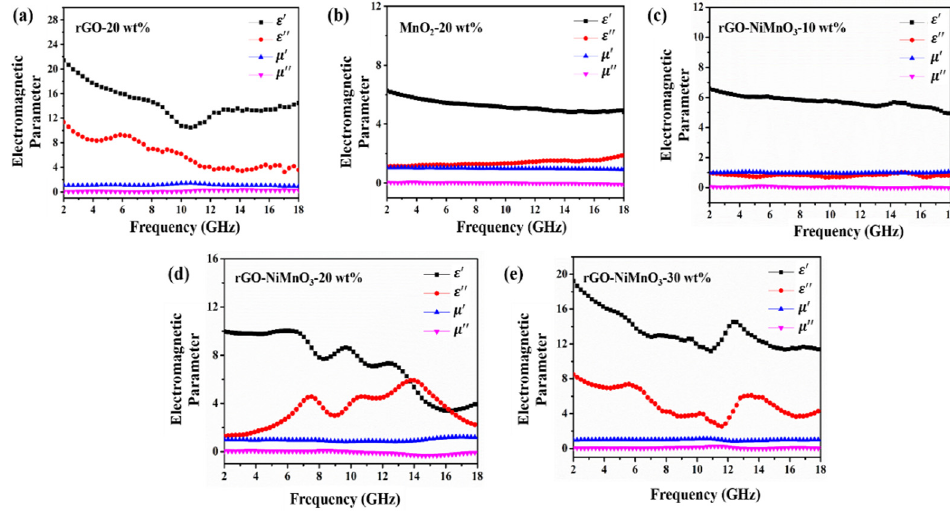
Figure 4. Electromagnetic parameters of rGO, MnO 2 , and rGO-NiMnO 3 , ( a ) rGO-20 wt%, ( b ) MnO 2 - 20 wt%, ( c ) rGO-NiMnO 3 -10 wt%, ( d ) rGO-NiMnO 3 -20 wt%, and ( e ) rGO-NiMnO 3 -30 wt%.